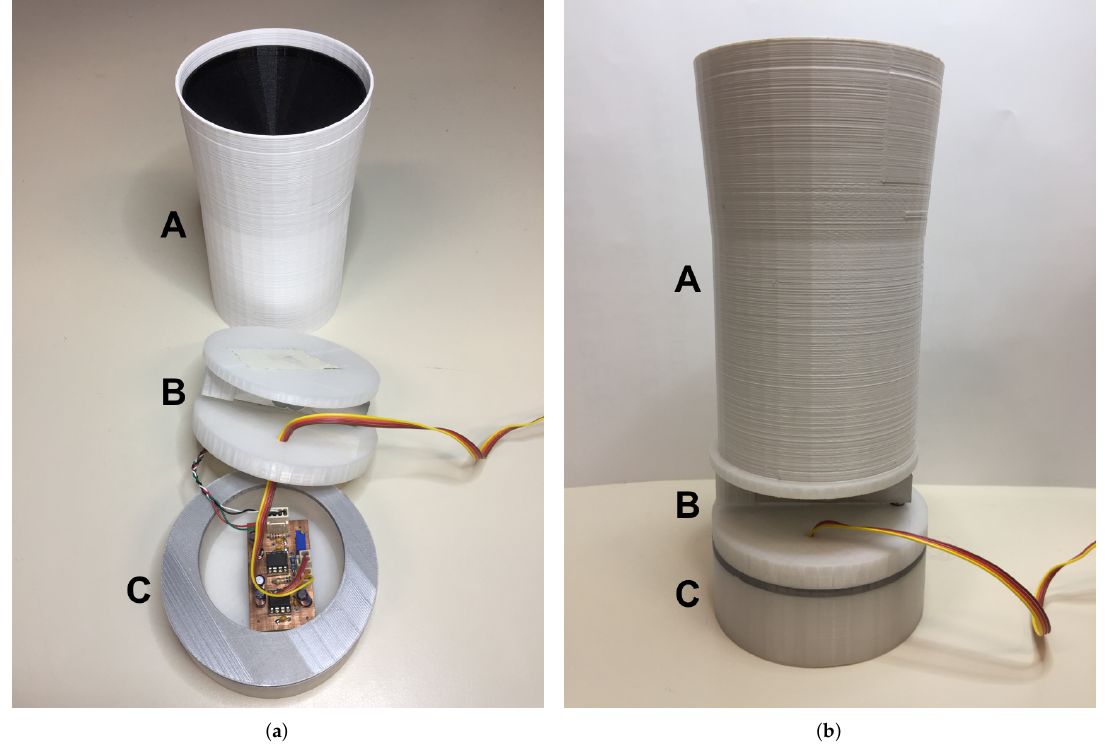
Figure 4. Prototype of the sensing structure: ( a ) decomposed into the individual parts (the basket (A), the load cell fixed to lower support and upper plate (B), the amplifier housing with circuit in the foreground (C)) and ( b ) mounted (the 4-line bus coming out from the amplifier housing connects amplifier and XBee radio module, placed at the top of the rotating